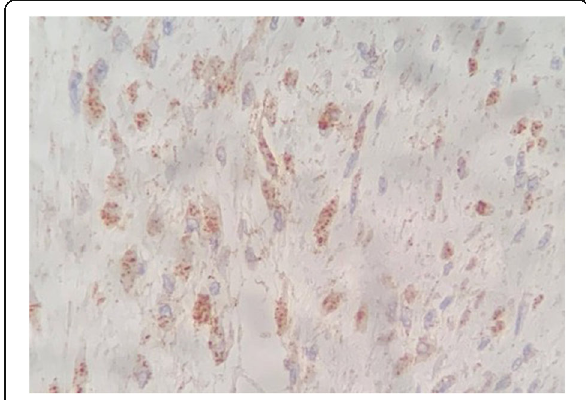
Fig. 5 Immunohistochemistry: positive for nuclear beta-catenin, the main immunohistochemistry marker of